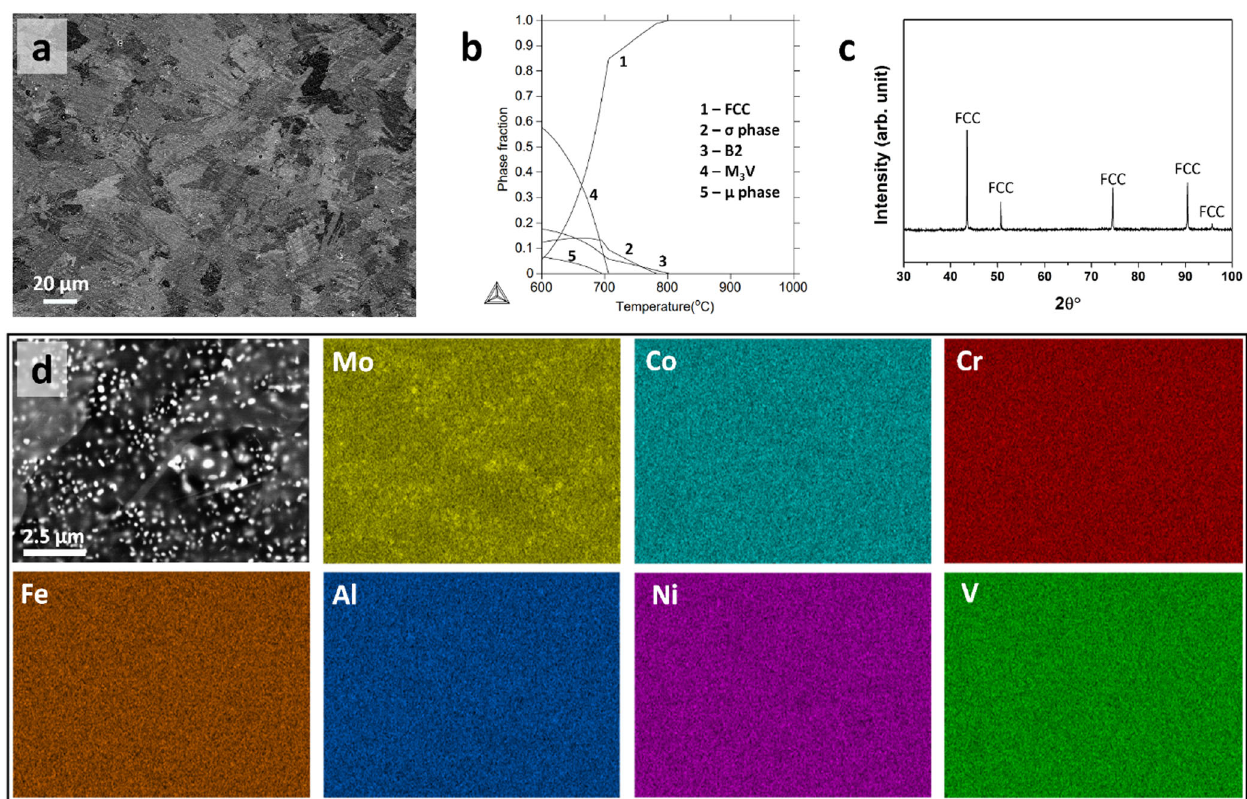
Fig. 5 Microstructure analysis of HEA2. a BSE-SEM image. b Mole fractions of equilibrium phases at various temperatures. c XRD pattern. d BSE image and corresponding EDS